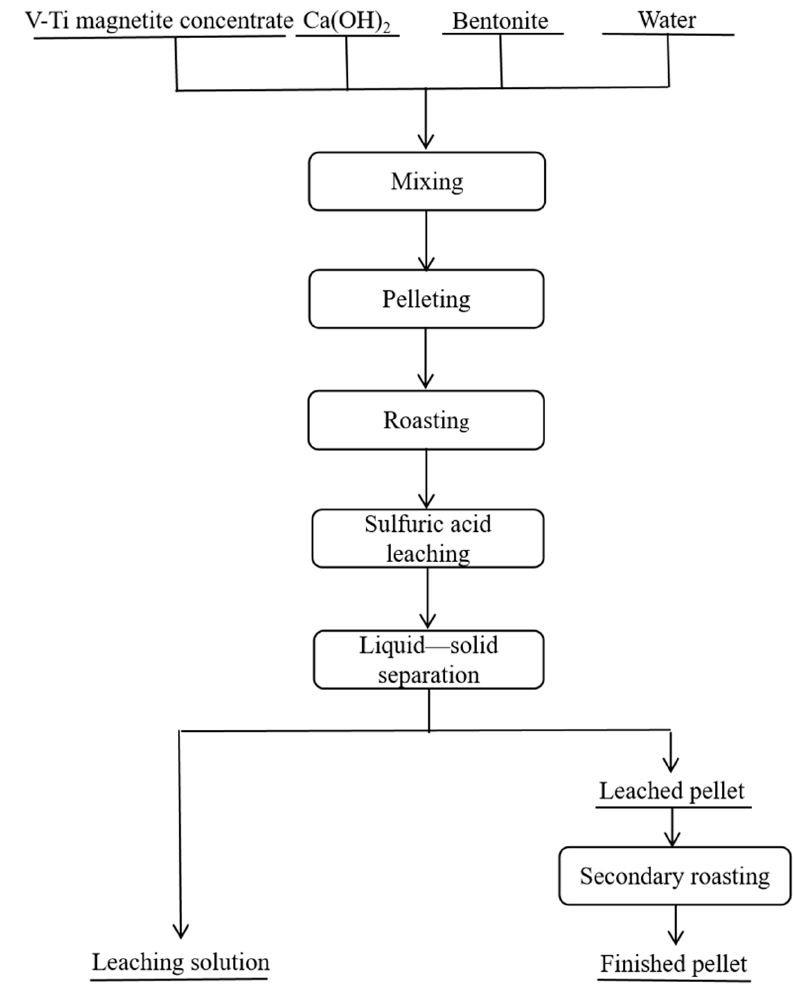
Figure 1. Flow chart of calcification roasting–sulfuric acid leaching method.